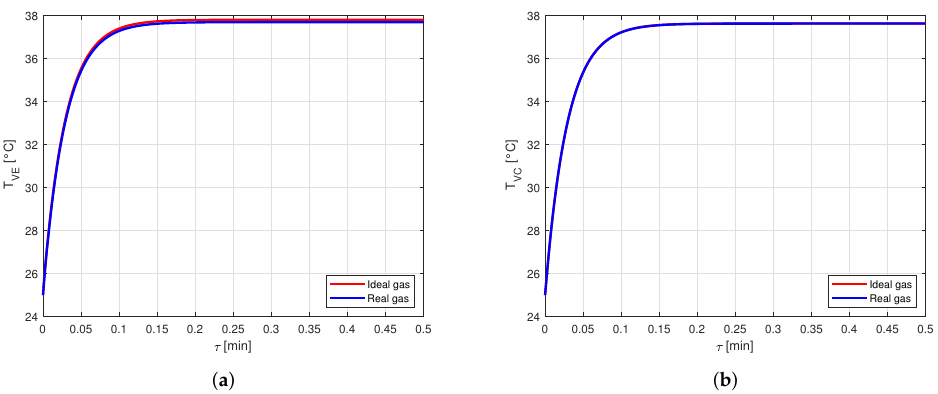
Figure 13. Comparison between the vapor temperatures obtained by modeling the vapor as ideal or real gas, in an aluminum-acetone heat pipe. ( a ) Comparison of the vapor temperatures at the evaporator. ( b ) Comparison of the vapor temperatures at the condenser.